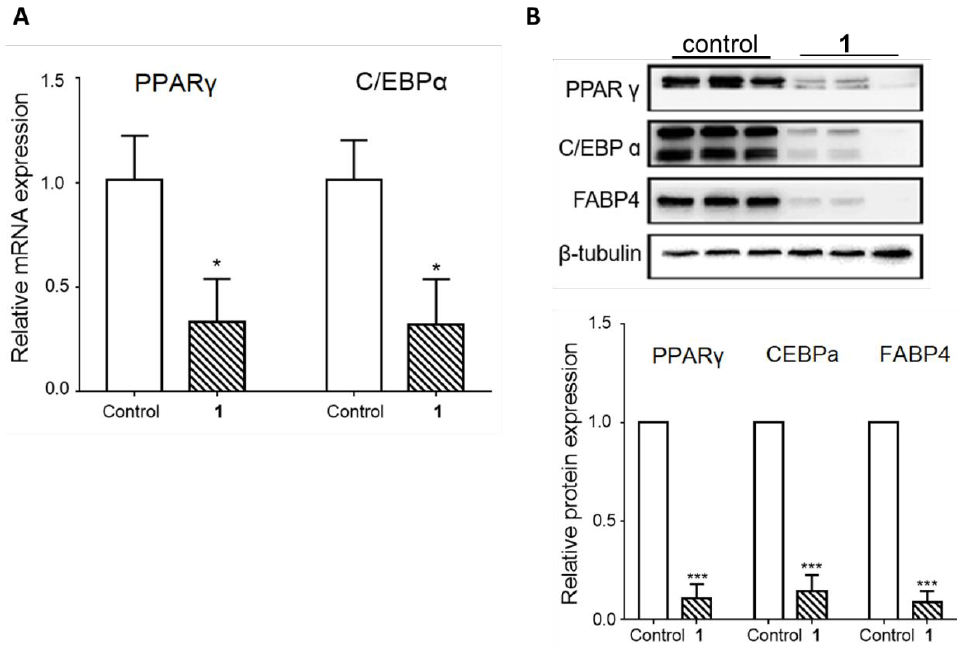
Figure 4. Effects of compound 1 on markers of adipocyte differentiation. 3T3-L1 preadipocytes were treated with 100 µM of compound 1 from the start of adipocyte differentiation (day 0) until the 4th day. ( A ) Gene expression of the adipogenic markers C/EBP α and PPAR γ on day 4 of differentiation. ( B ) Representative image and quantification of C/EBP α , PPAR γ , and FABP4 protein expression on day 4 of differentiation. The values are the means ± SEM of three experiments. * p < 0.05 vs. control, *** p < 0.001 vs. control.